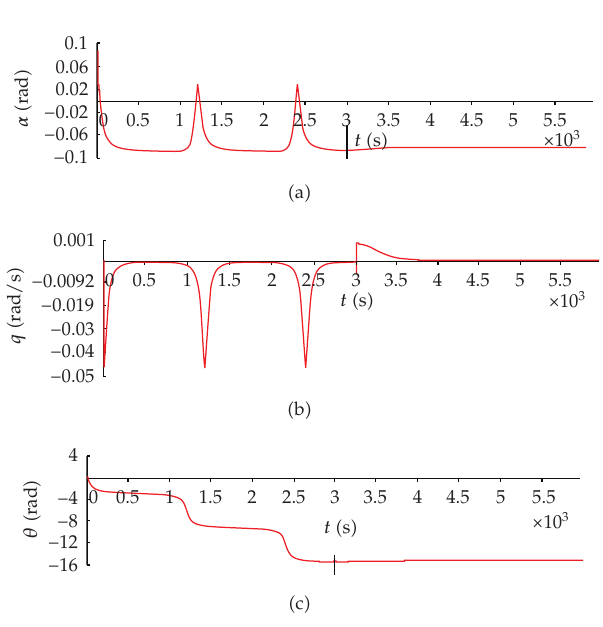
(cid:6) (cid:7) − 0 . 04678 (cid:5) rad (cid:6) (cid:7) − 2 . 681 ◦ after 3000 (cid:5) s (cid:6) of e to δ e